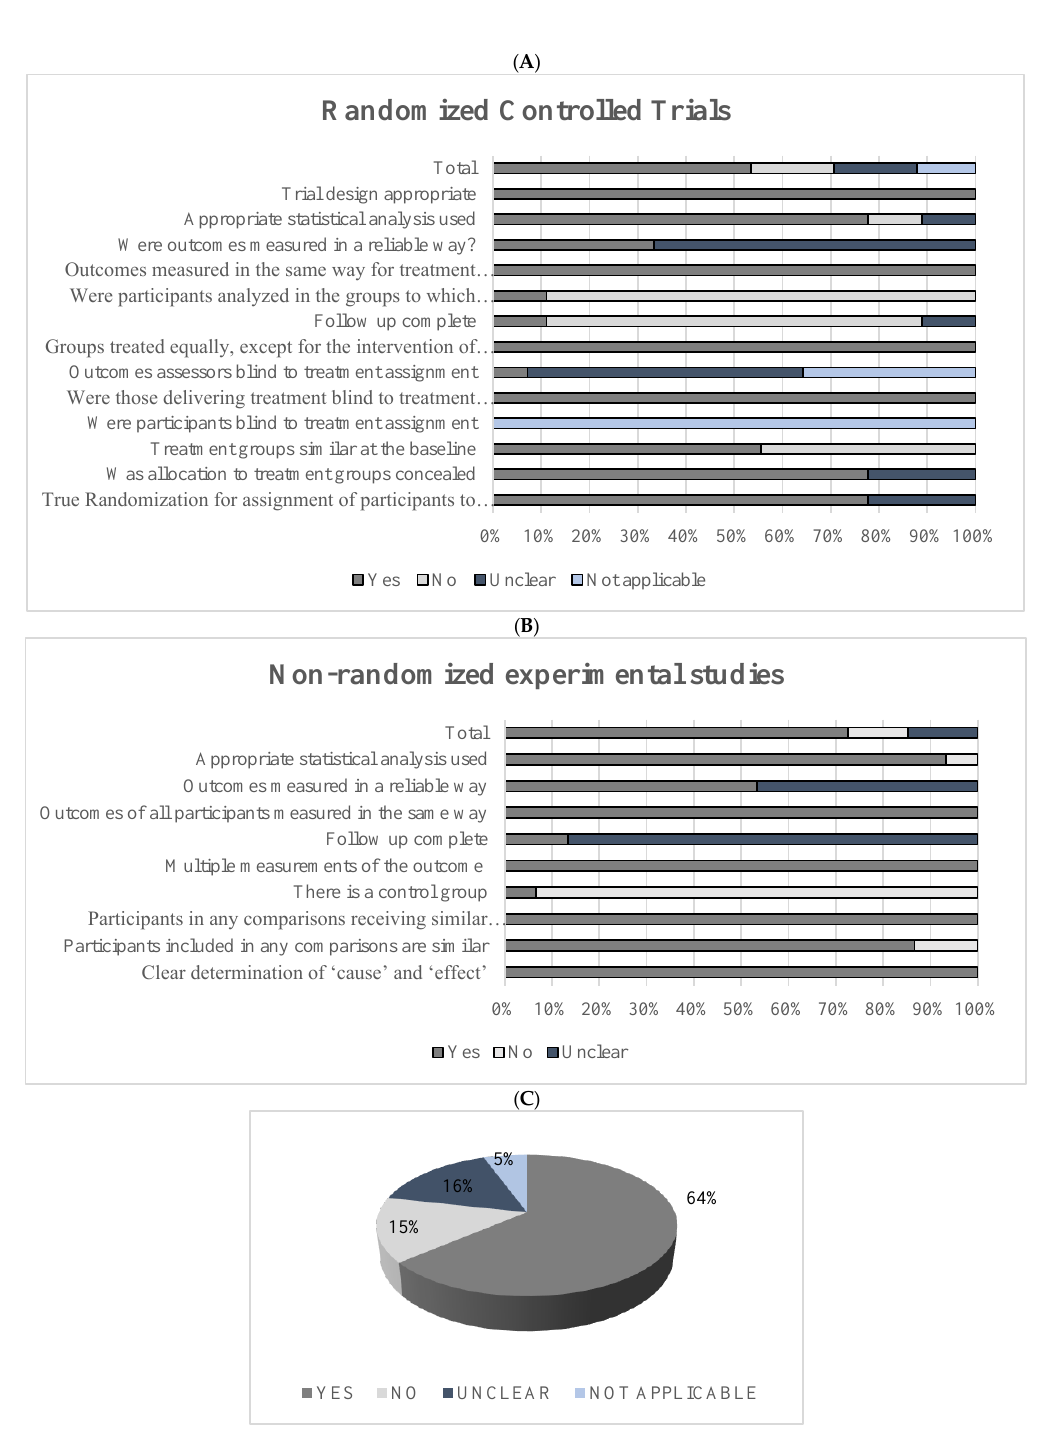
Figure 2. Assessment of studies’ bias risk following the Joanna Briggs Institute (JBI) Reviewer’s Manual . ( A ) Risk of bias assessment of randomized clinical trials ( n = 9); ( B ) Risk of bias assessment of non-randomized clinical trials ( n = 15); ( C ) Total score.